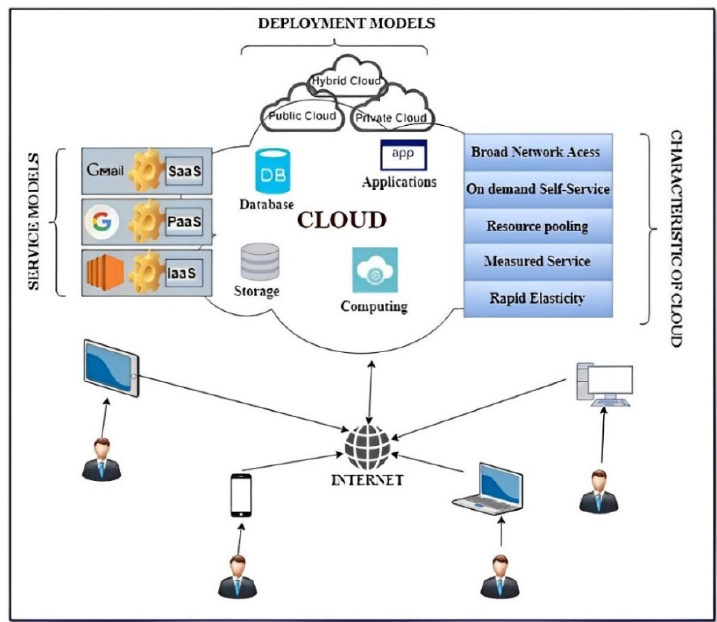
Figure 2. Cloud Computing Overview [17].